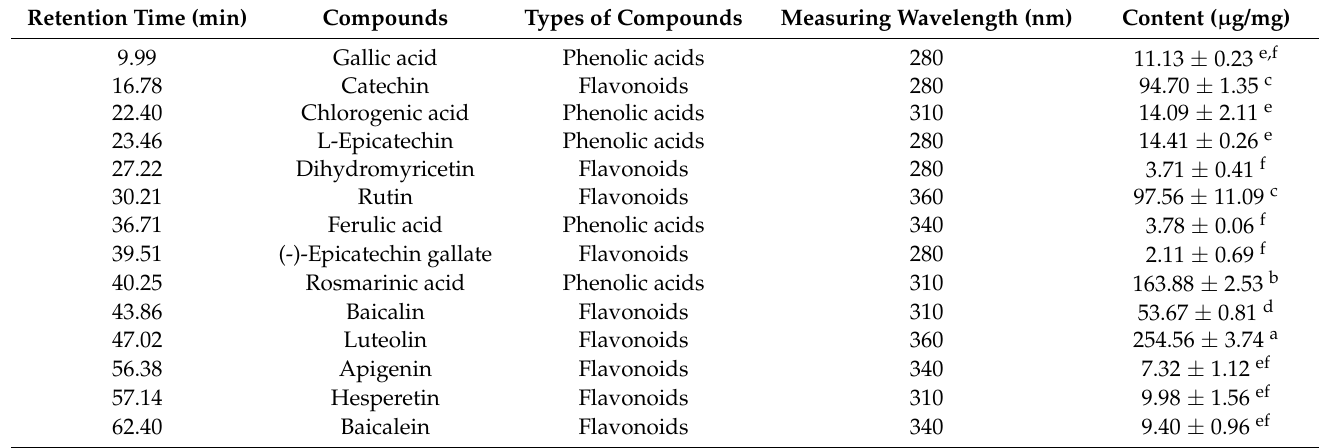
Table 3. The HPLC analysis of the ethyl acetate fraction of P. frutescens